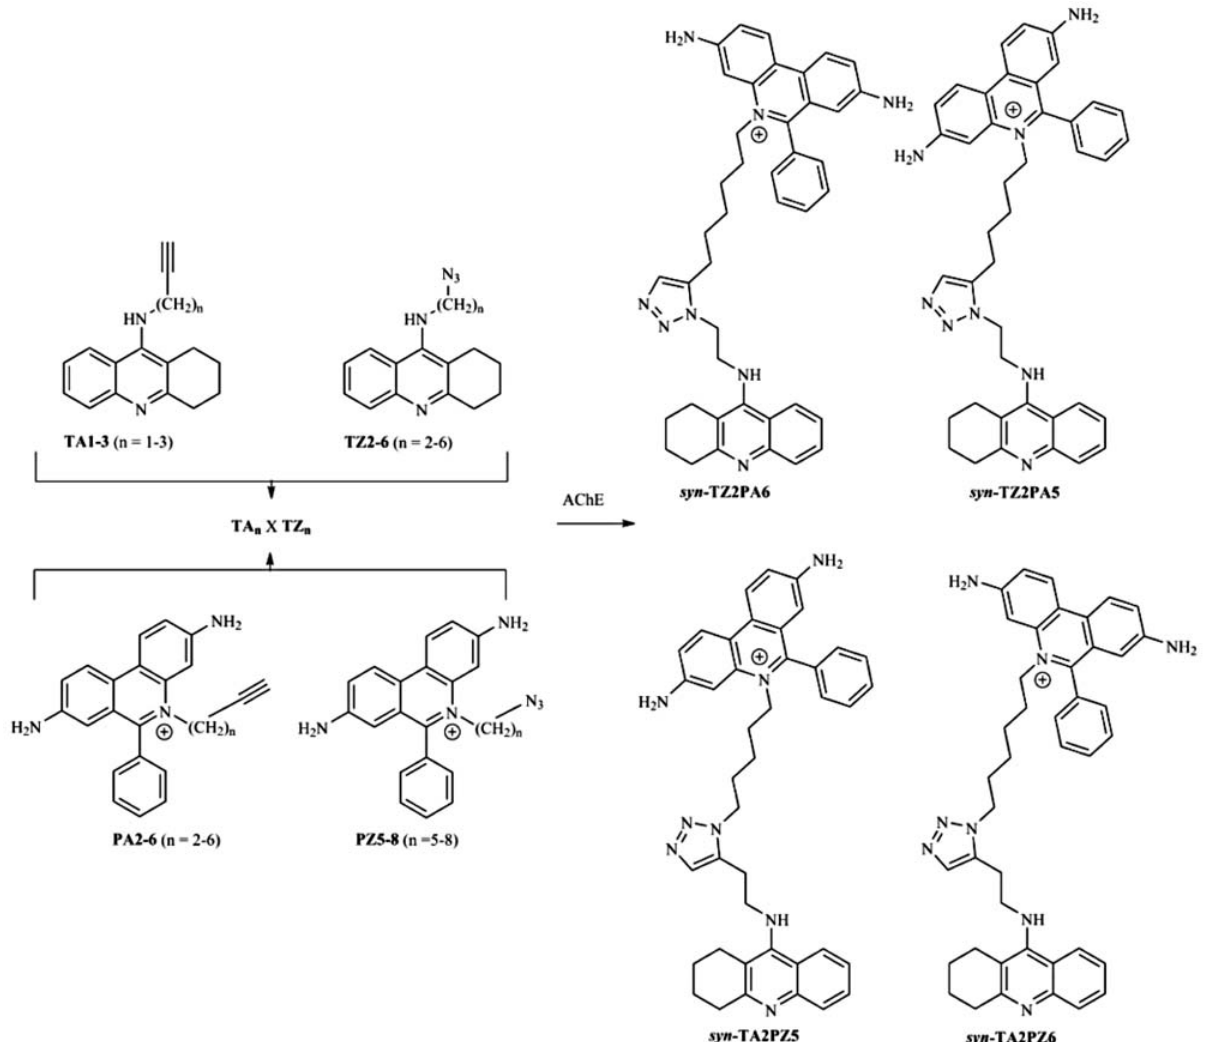
Figure 12. In situ click chemistry screening of binary mixtures of tacrine/phenylphenanthridinium-based building blocks for the discovery of biva- lent inhibitors to AChE.